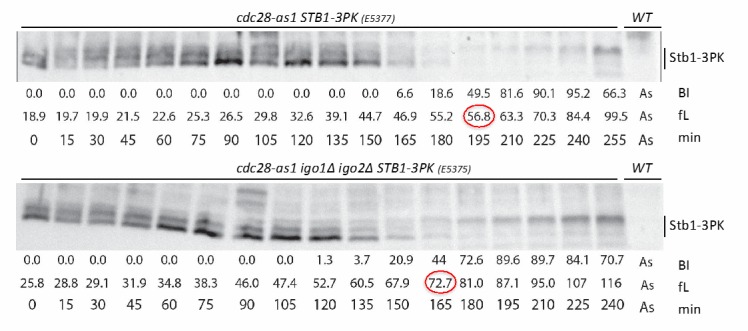
DOI:
http://dx.doi.org/10.7554/eLife.26233.017